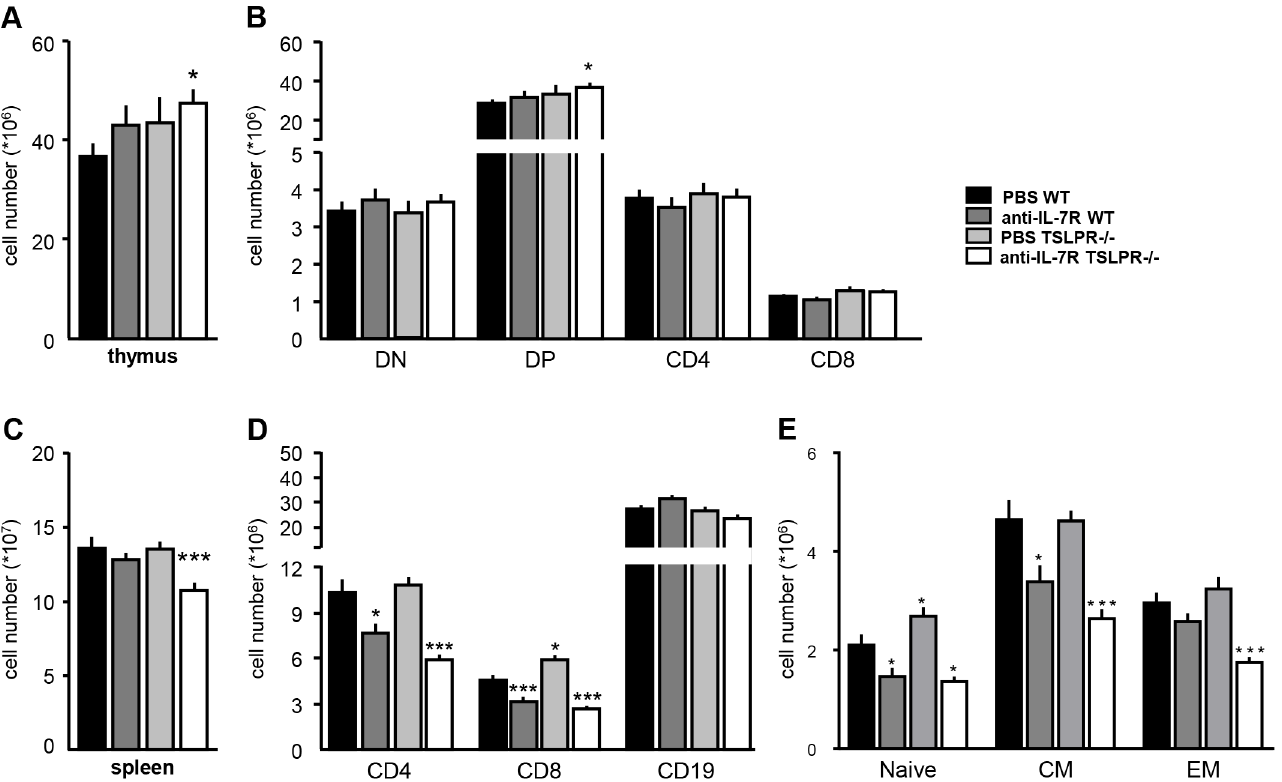
Fig 2. TSLPR-deficiency and IL-7R blockade alter numbers of thymocytes and splenocytes. Total numbers of thymocytes were modestly increased in anti-IL-7R treated TSLPR-/- mice as compared to PBS treated WT mice (A), associated with an increase in CD4+ CD8+ double positive (DP) thymocytes (B). Total numbers of splenocytes were decreased in anti-IL-7R treated TSLPR-/- mice compared to PBS treated WT mice (C), associated with a decrease in CD4+ and CD8+ T-cells in the anti-IL-7R treated TSLPR-/- mice (D). The number of CD4+ T-cells with characteristics of naive (Naive; CD44-CD62L+), central memory (CM; CD44+CD62L+) and effector memory (EM; CD44+CD62L-) T-cells were significantly decreased in anti-IL-7R TSLPR-/- mice as compared to PBS WT mice. Values are mean ± SEM of 16 mice per group. * and *** indicate statistical differences of p < 0.05 and p < 0.005 respectively.